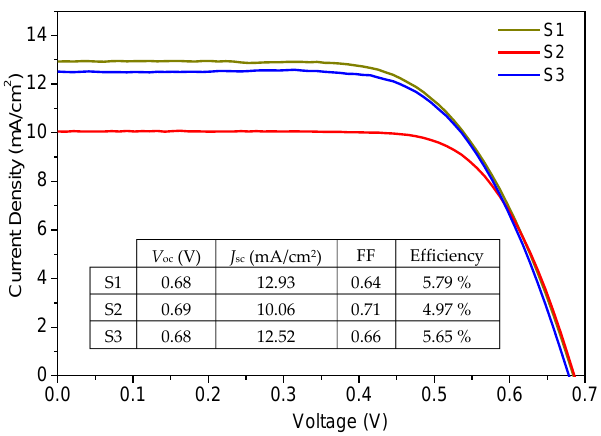
Figure 4. J - V curves for best devices fabricated using S1, S2, and S3 samples. The strong scattering e ff ect within the TiO 2 layer in the S3 sample could almost retrieve the photocurrent of S1 made of monodispersed TiO 2